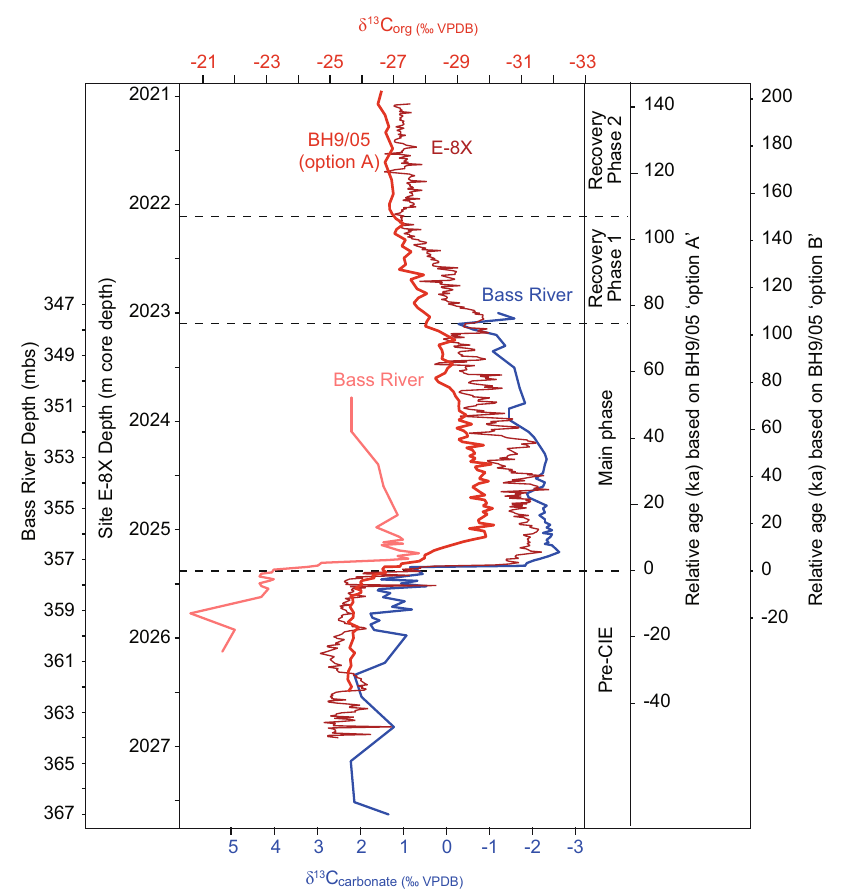
Fig. 3 Carbon isotope correlation of two sites with Svalbard core BH9/05. The δ 13 C of both organic carbon ( δ 13 C org ) and inorganic carbonate ( δ 13 C carbonate ) from North Sea well site E − 8X (this study) and Bass River 38 , are correlated to Svalbard core BH9/05 (ref. 40 ) based on the overall shape of the records, with particular emphasis on the carbon isotope excursion (CIE) in fl ection points during the rapid onset and gradual recovery phases. The relative age model is based on two proposed solutions for cyclostratigraphy of core BH9/05 (ref. 40 ). Bass River core depth in metres below the surface